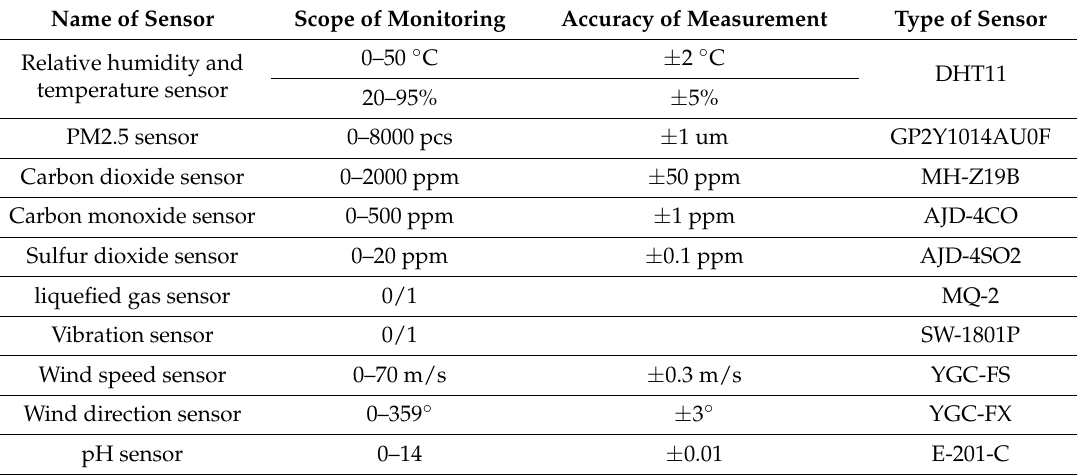
Table 1. The types of sensors and technical parameters used in the monitoring system.